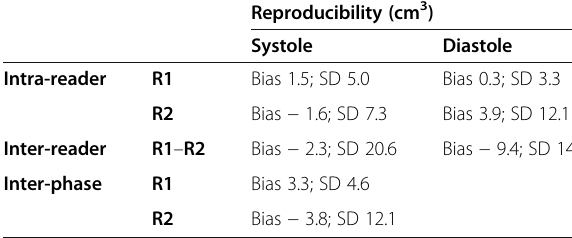
Table 3 Results of Bland-Altman analyses for the assessment of intra-reader, inter-reader and inter-phase (systole and diastole)